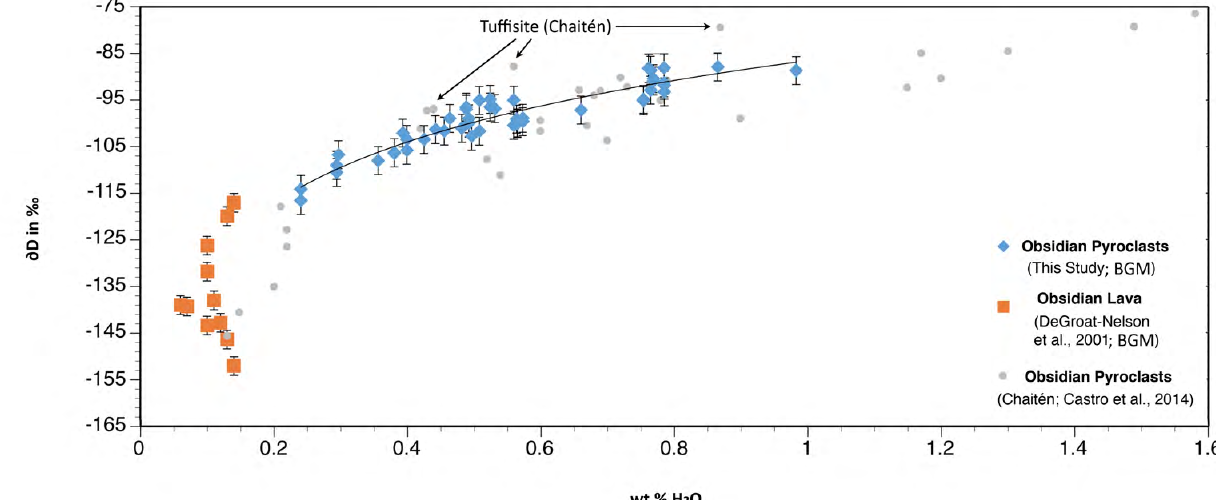
Figure 5: δ D–H 2 O (bulk) compositions of Big Glass Mountain rhyolite. Blue diamonds are obsidian pyroclasts analyzed in this study whereas orange squares are data collected by DeGroat-Nelson et al. [2001] on flow margin obsidian lavas. Grey circles are data derived from pyroclasts sampled from Chaitén volcano by Castro et al. [2014]. Error bars demarcate the measurement uncertainty for the TCEA-method applied in this study (isotopic error is ˘ 3 o { oo ), whereas the DeGroat-Nelson et al. [2001] data carry a ˘ 2 o { oo error. Measurement uncertainty in H 2 O contents (determined by FTIR; ~0.01 wt.%) are well within the breadth of the symbols. The curve fit (R 2 = 0.88) to the pyroclastic obsidian data is a logarithmic expression of form: y = 17.6 ln( x ) ´ 87.7; meant for statistical representation of trend and not as a degassing